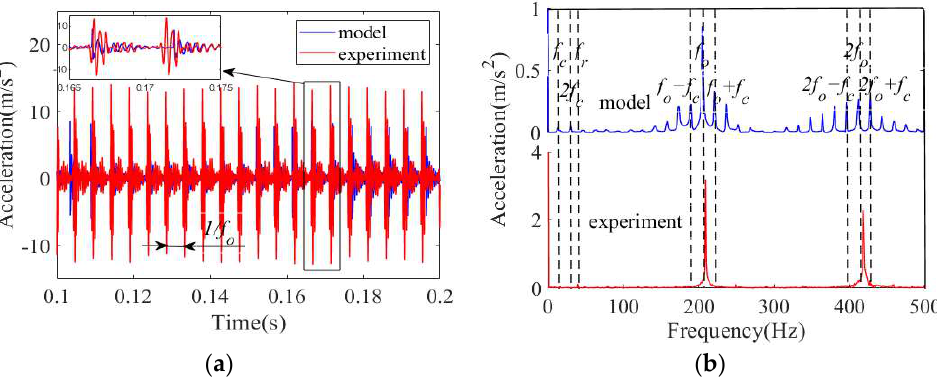
Figure 8. The comparison results for time-domain and frequency responses under outer ring defect: ( a ) acceleration signals; ( b ) envelope spectrum.